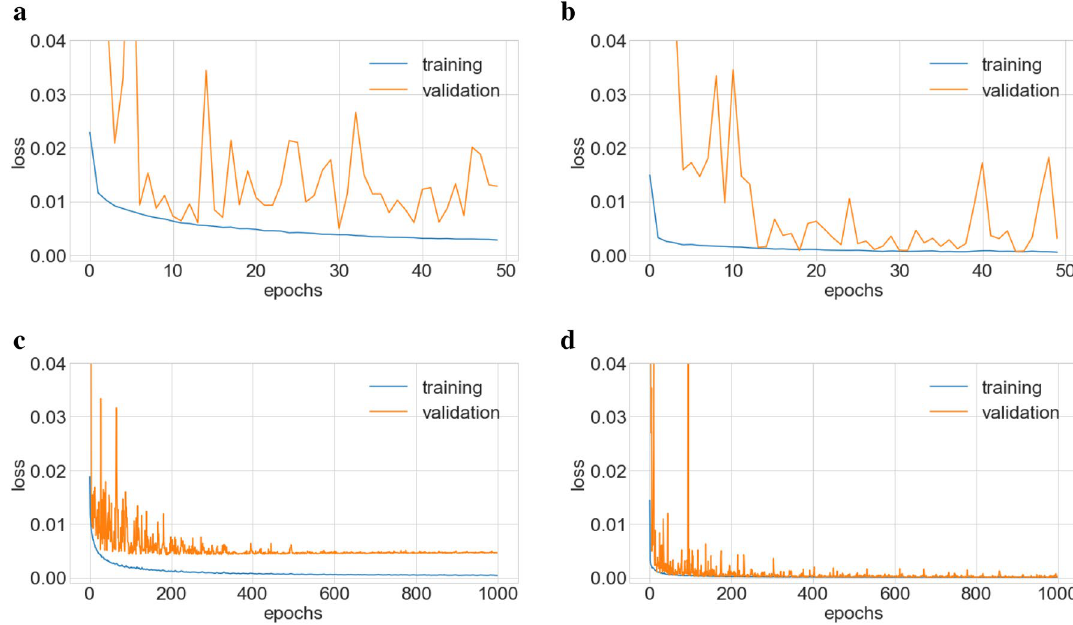
Fig. 5 Autoencoder training results for CARLA dataset: a for model 1, b for model 2, c for model 3, d for model